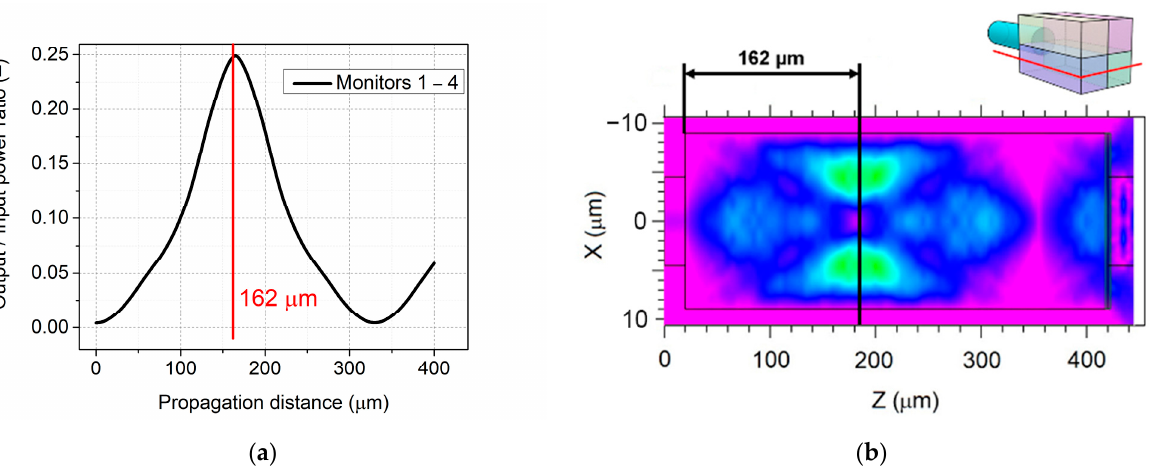
Figure 3. Power distribution throughout the 1 × 4 MMI: ( a ) Values of power for each monitor against propagation distance with optimal L π denoted by the red line; ( b ) Cross section of the power distribution at the central axis of the bottom two outputs.